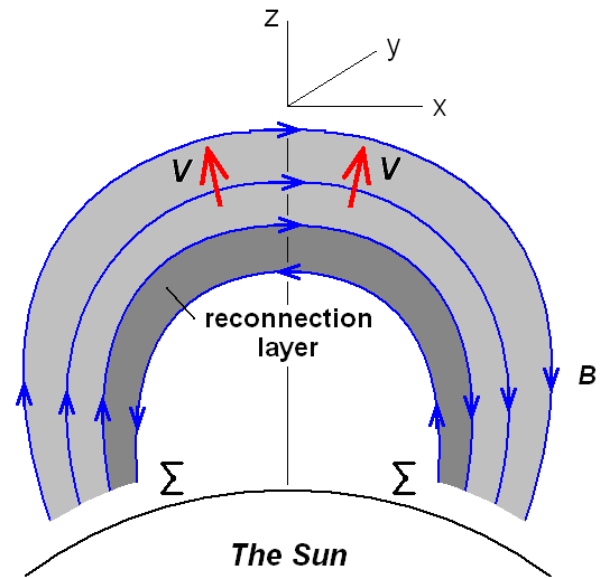
Fig. 10. A schematic showing upward motion of a magnetic flux tube, filled with hot plasma, when the ends of this tube are immersed in a conducting layer near the solar photosphere. The flux tube, filled with plasma heated in the reconnection layer, is rising upward at a velocity V ; 6 is the height-integrated conductivity of the solar photosphere. The blue lines show the magnetic field lines.